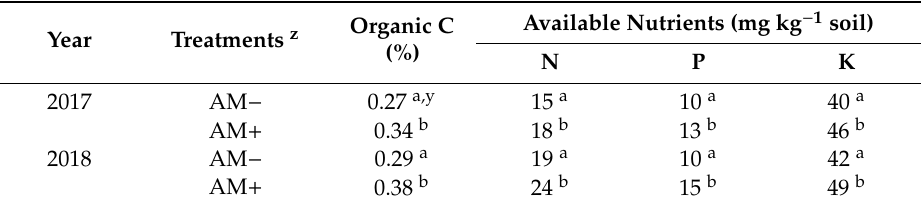
Table 5. Residual soil fertility after the harvest of eggplant subjected to varying water stress and AM